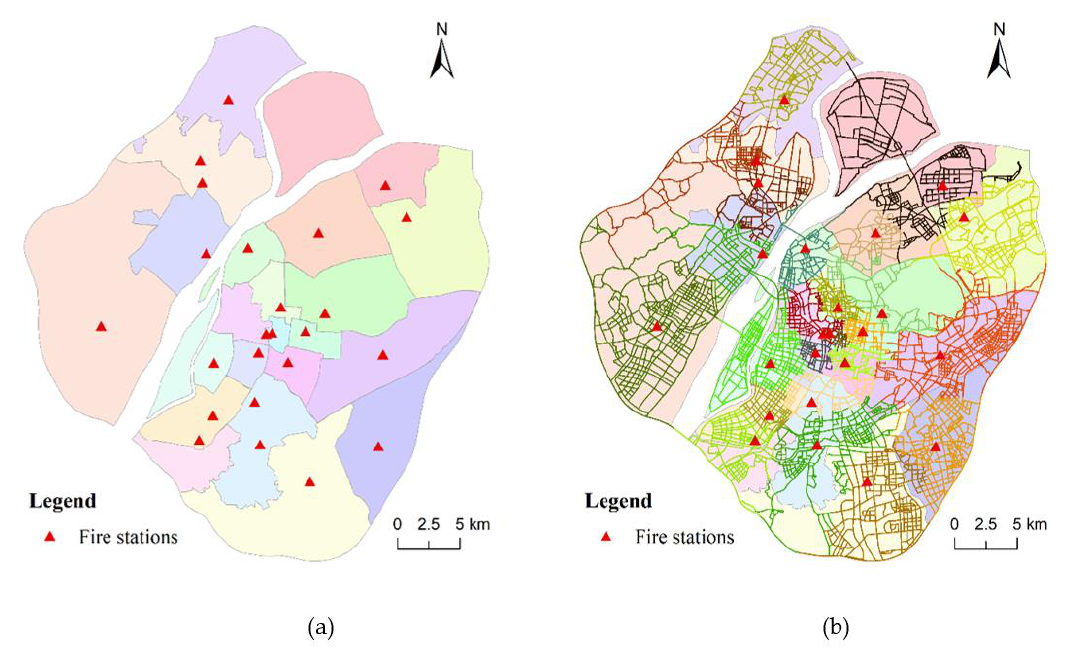
Figure 12. The official division of service area of fire stations ( a ) and the overlap of the result generated by our method and the official result ( b ).